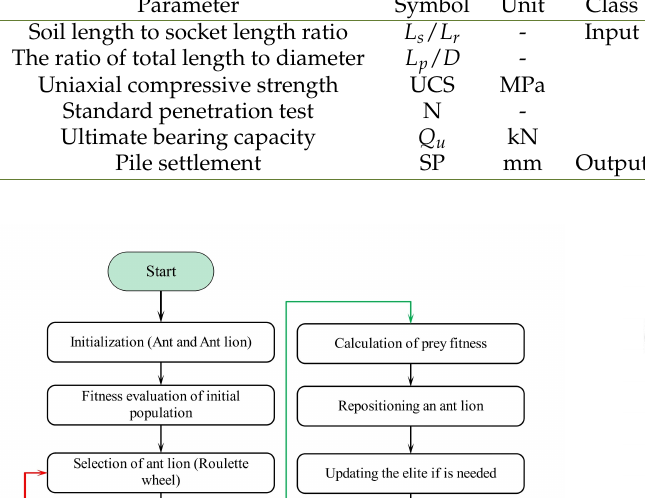
Fig. 4. (a) Random walk of the prey inside the trap, and (b) hunting behavior of ant lions